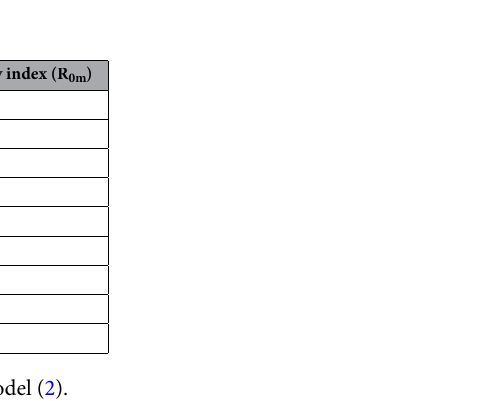
Figure 4. PRCC values depicting the sensitivity of the multidrug-resistant basic reproduction number R 0m with respect to the parameters β , α , φ , δ , γ m , τ m , κ , η m and c .